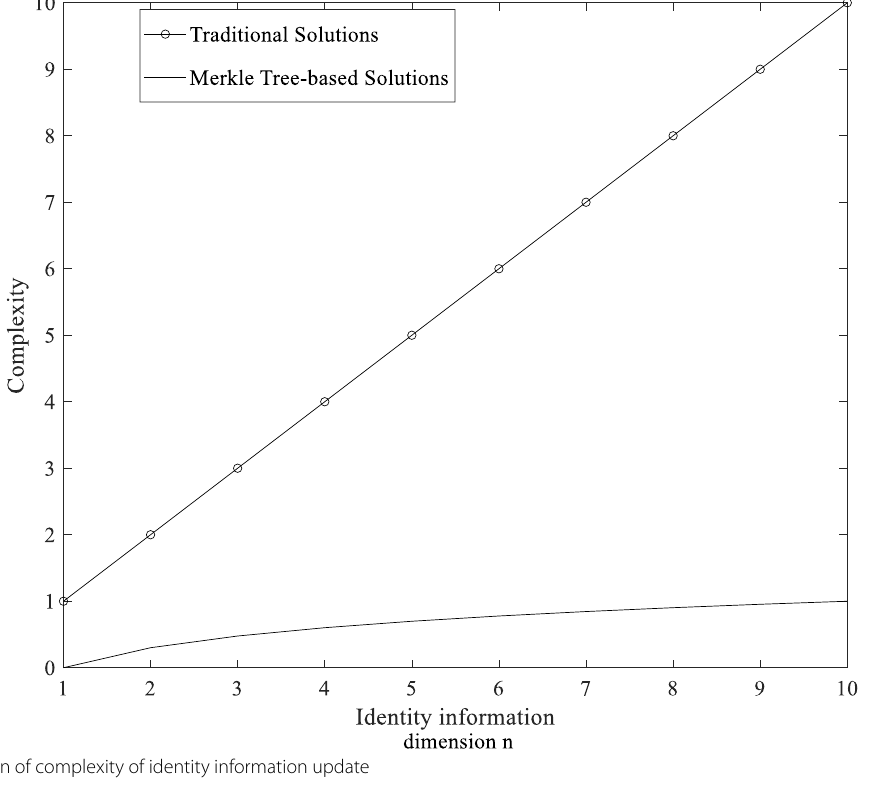
Fig. 11 Comparison of complexity of identity information update